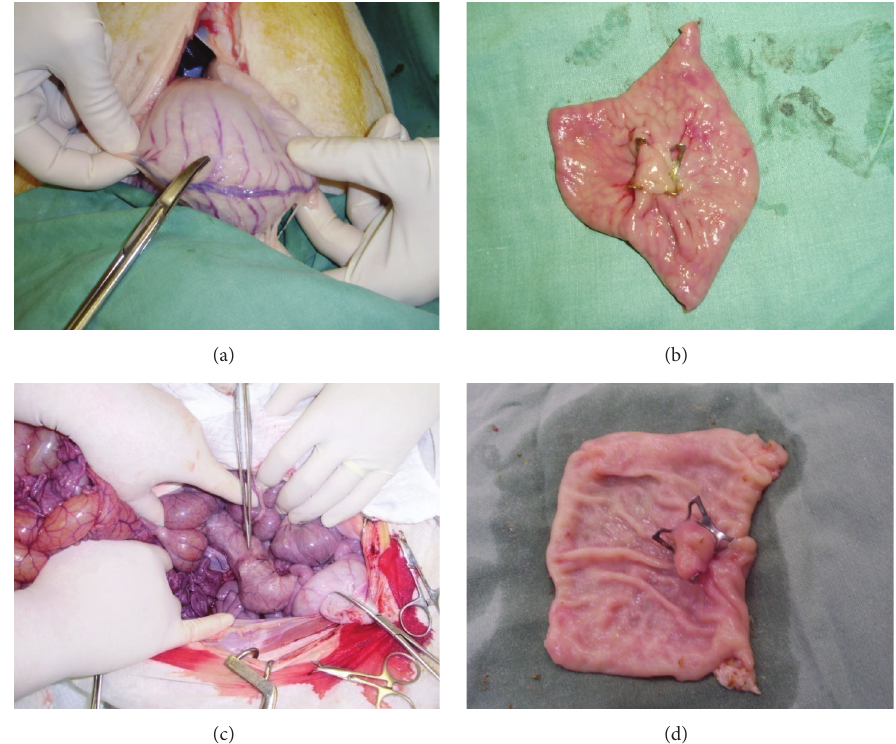
Figure 1: OTSC closure in stomach and colon at autopsy. (a) Serosal site of stomach closure. (b) Mucosal site of stomach closure. (c) Serosal site of colon closure. (d) Mucosal site of colon closure.